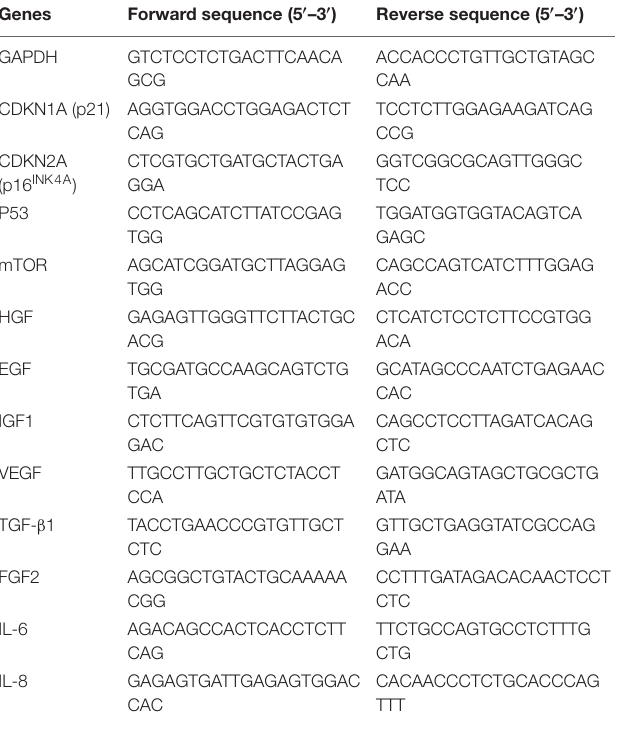
TABLE 1 | Primers used for the amplification of human transcripts by real-time quantitative PCR.